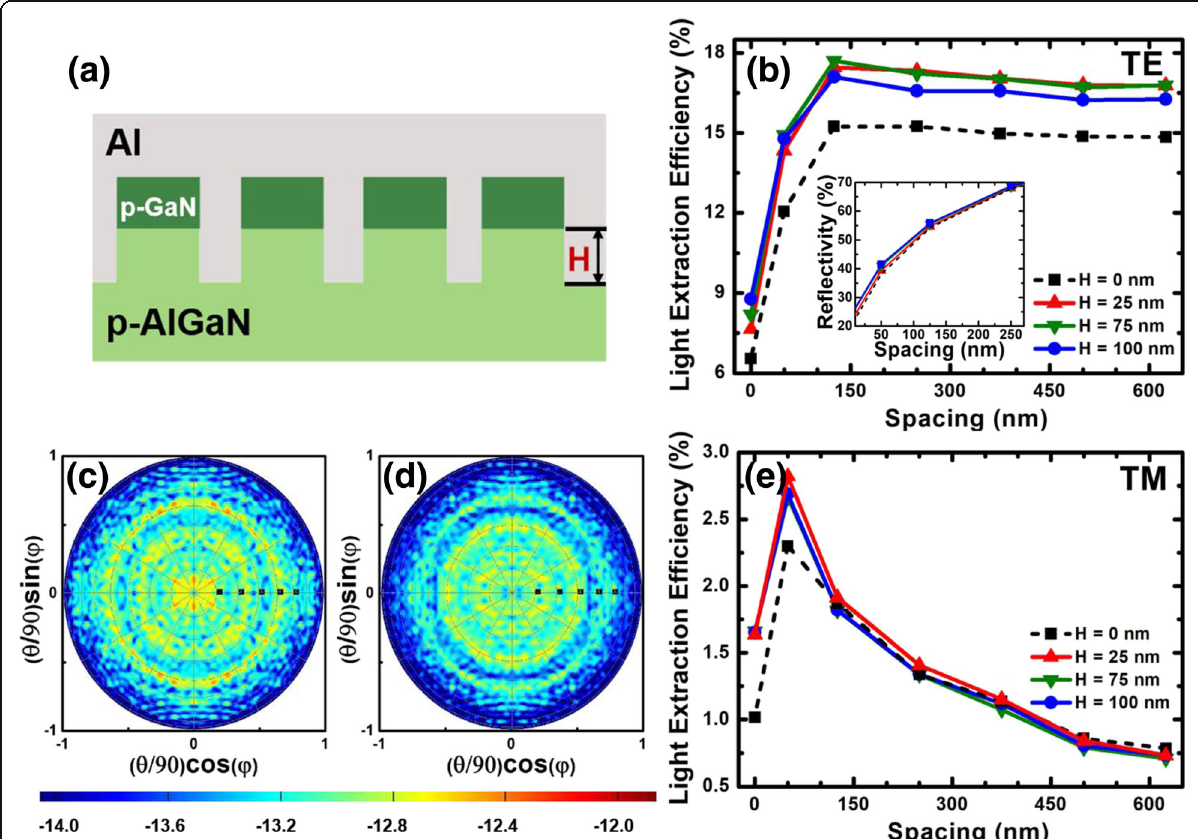
Fig. 5 a Schematic side view diagram for flip-chip DUV LED with hybrid p-GaN/p-AlGaN nanorod-based meshed contacts. b LEEs for TE-polarized light as a function of the nanorod spacing and the p-AlGaN nanorod heights are set to 0, 25, 75, and 100 nm. Inset: Reflectivity of normal incidence for DUV LED with the 100-nm-high p-GaN and with the p-AlGaN height of 0, 25, 75, and 100 nm as a function of the nanorod spacing. Far-field radiation patterns at a spacing of 125 nm with p-AlGaN height of c 75 nm and d 0 nm. e LEEs for TM-polarized light as a function of the nanorod spacing and the p-AlGaN nanorod heights are set to 0, 25, 75, and 100